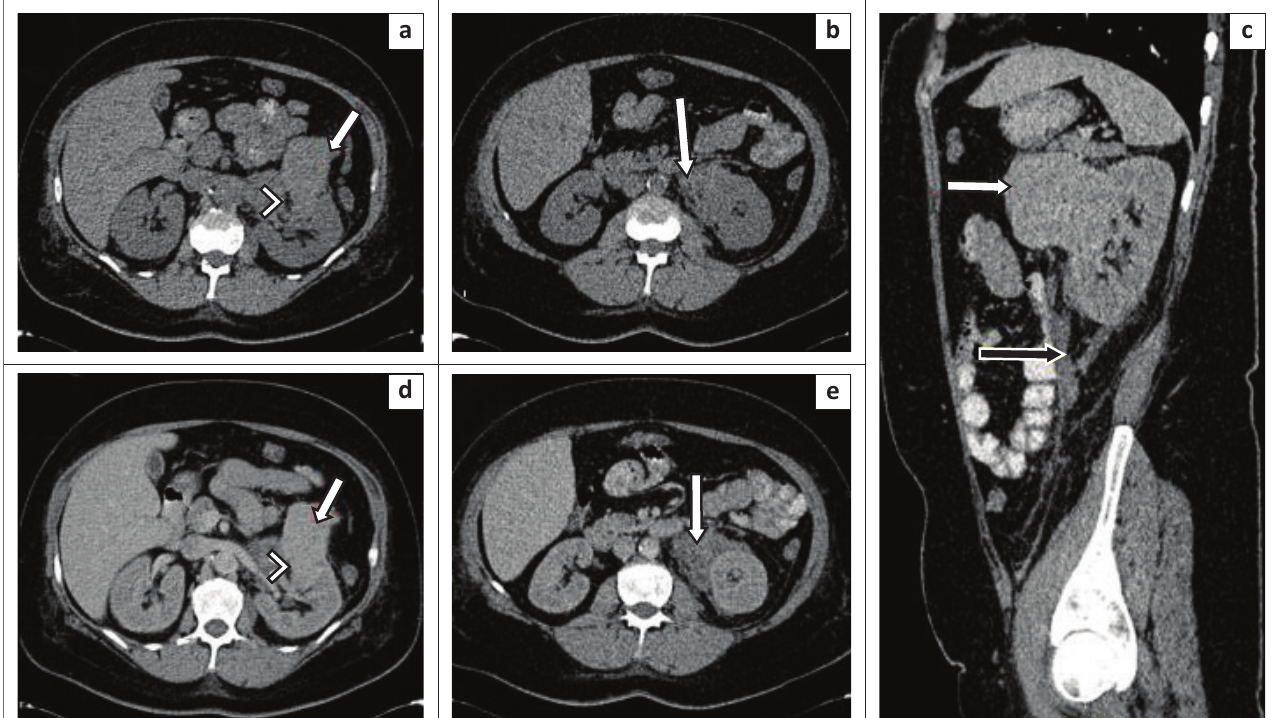
FIGURE 7: (a, b) Non-enhanced axial computed tomography (CT) images show a large exophytic high-density soft tissue mass arising from the left kidney mid pole anteriorly (arrow in image a), perinephric haemorrhage and fat stranding (white arrow in image b). Sagittal (c) – There is also thickening of the Gerota’s fascia (black arrow). Portovenous phase axial images (d) and (e) demonstrate mild enhancement of the renal mass and the perinephric collections. A small focus of intralesional fat (arrowhead) is demonstrated by an arrowhead in the image (a, d). This was diagnosed as haemorrhagic renal cell carcinoma on CT scan, and histology results showed angiomyolipoma